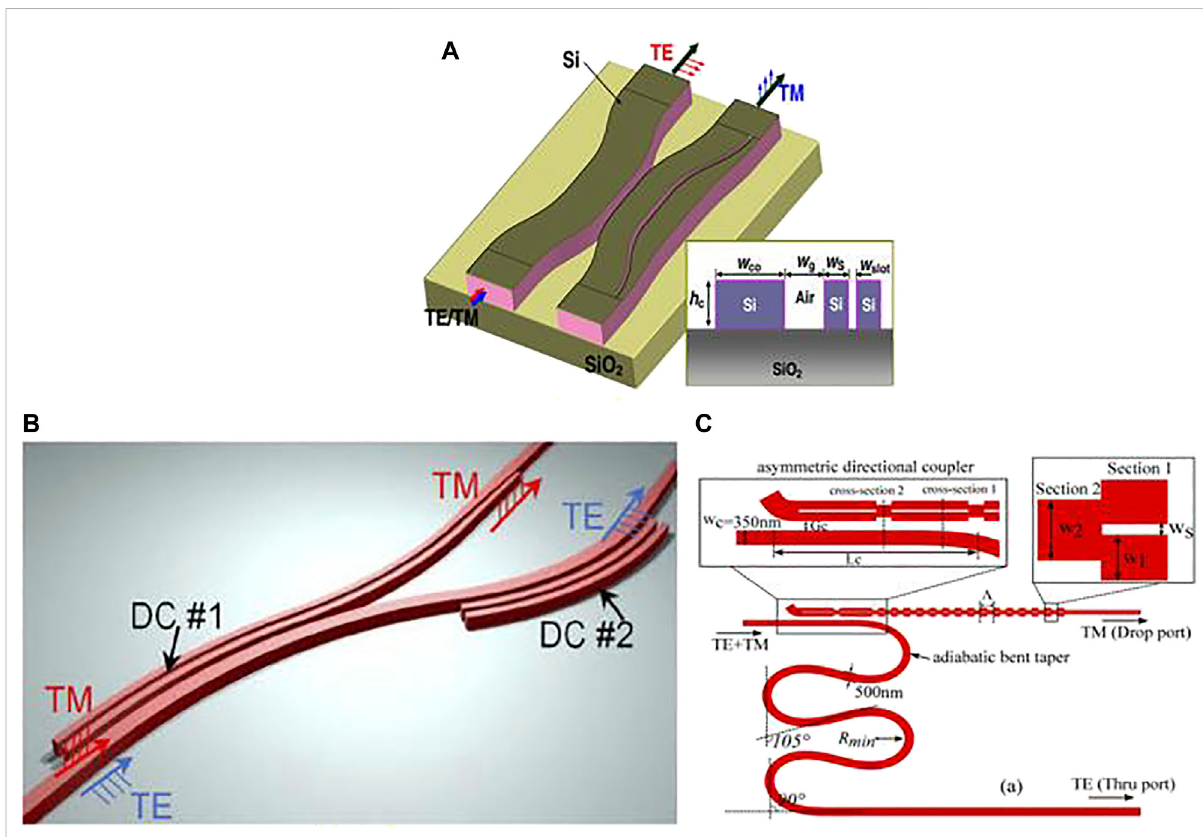
FIGURE 6 OptimaldesignofasymmetricDC. (A) DCcomposedofdifferenttypesofwaveguides[70]. (B) CascadedDCforpolarizationbeamsplitting[127]. (C) Polarization splitter with periodic etched structure and curved waveguide [131]. Figure reproduced with permission from: (A) , © 2011, Optical Society of America (OSA); (B) , © 2021, Optical Society of America (OSA); (C) , © 2020, Optical Society of America